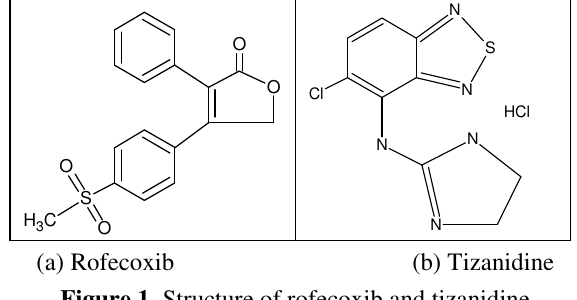
Figure 1. Structure of rofecoxib and